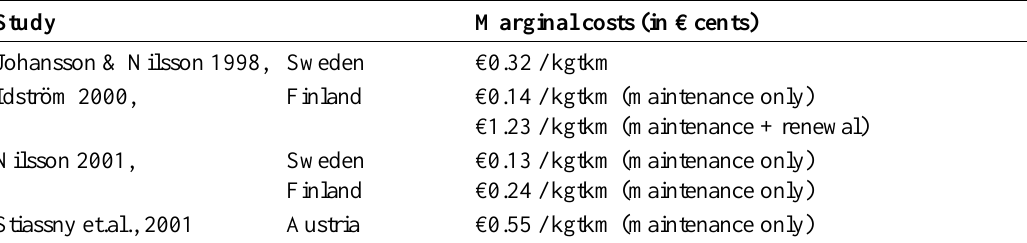
Table 2. Marginal costs from different studies Study Marginal costs (in € cents) Johansson & Nilsson 1998,